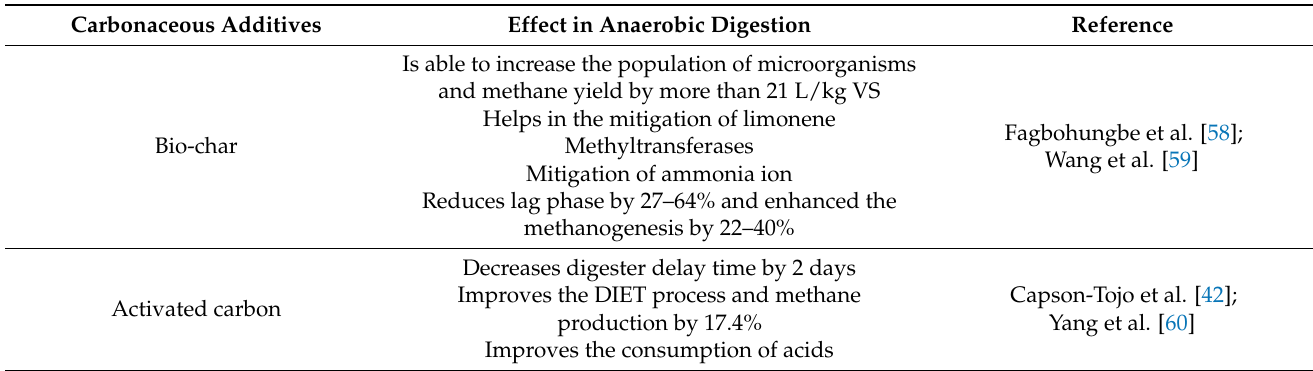
Table 2. Effect of biochemical conductive substrates for syntrophic